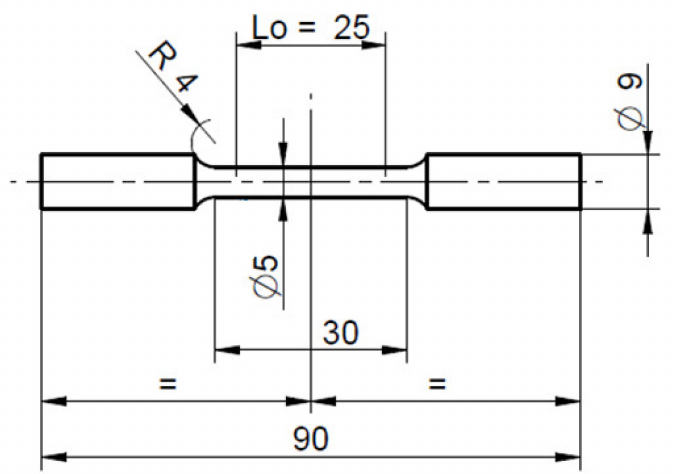
Figure 14. Dimensions of specimens for tensile testing prepared from preforms and forgings.